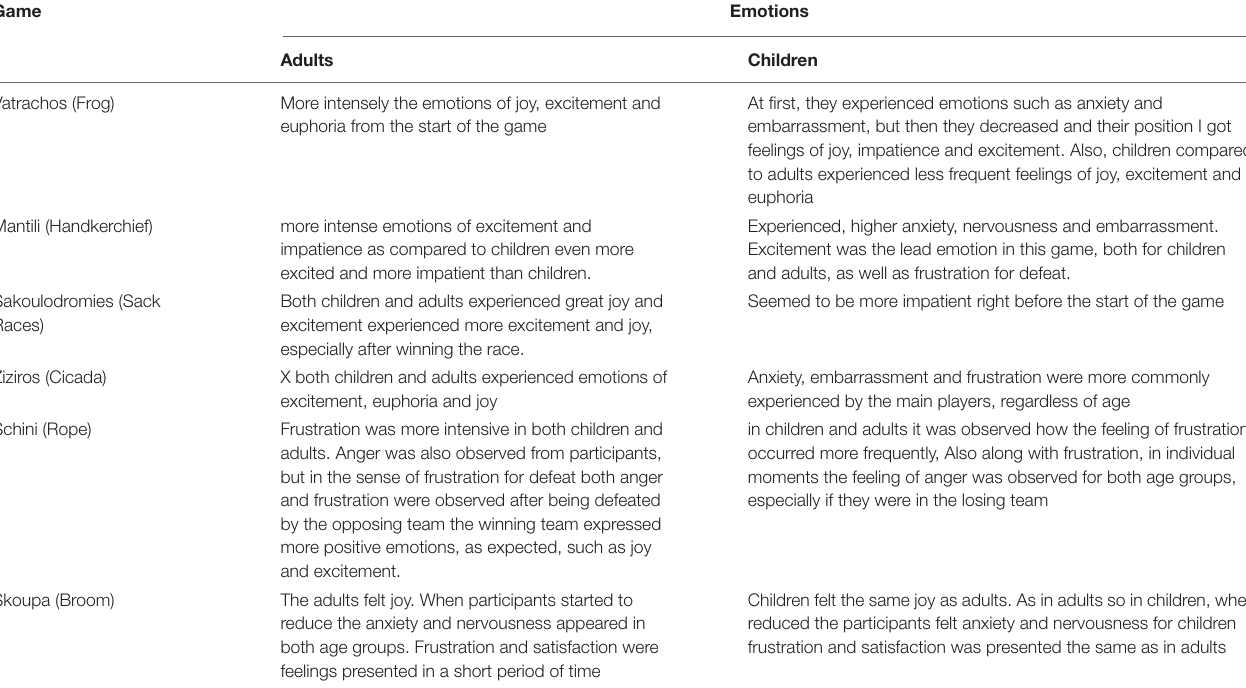
TABLE 3 | Emotions in each game according to age group. Game Emotions